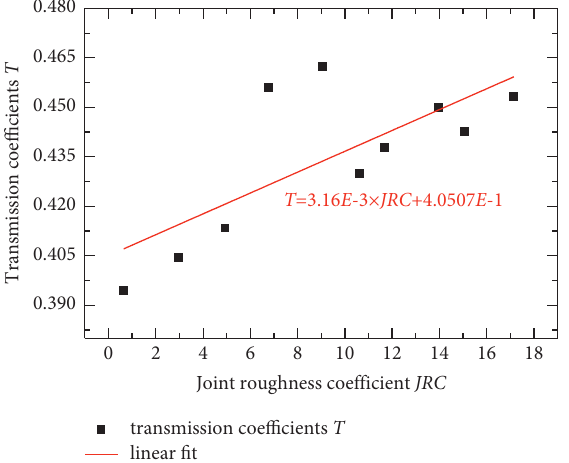
Figure 6: The variation of transmission coefficient with JRC of specimen.